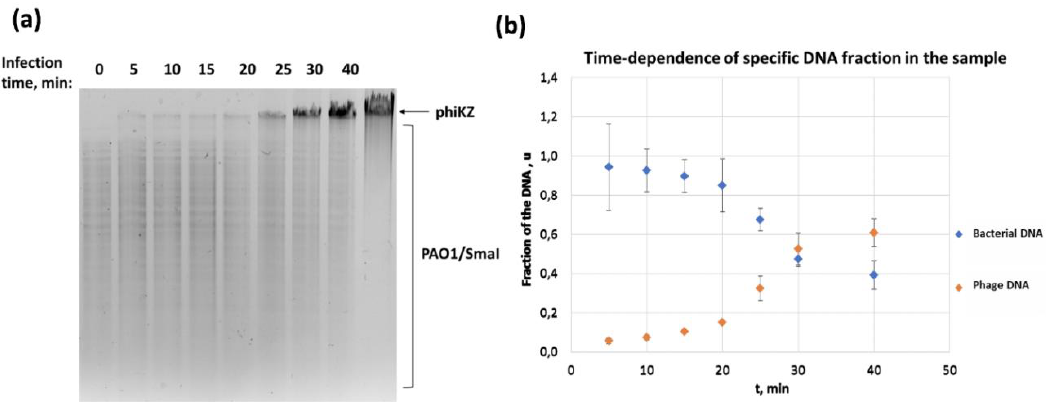
Figure 4. Analysis of the total DNA content from phiKZ-infected cells. ( a ) agarose gel-electrophoresis. Above the gel, the time points are mentioned, where ‘0′ is a non-infected cell, and the last line is the total DNA from phiKZ virions. PAO1/SmaI — bacterial DNA cleaved by SmaI REase. ( b ) real-time PCR results. Blue diamonds-bacterial DNA, orange diamonds-phage DNA.